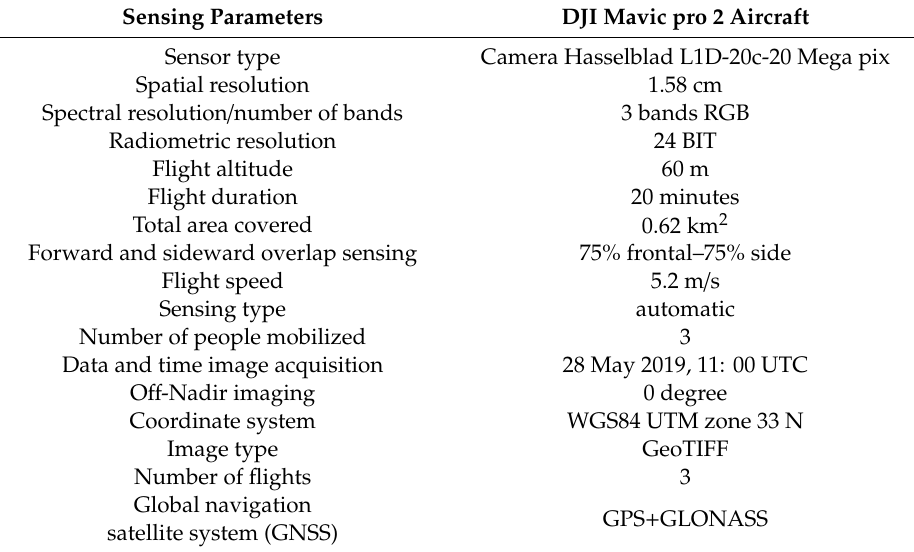
Table 3. Aircraft sensing parameters and main characteristics of UAV